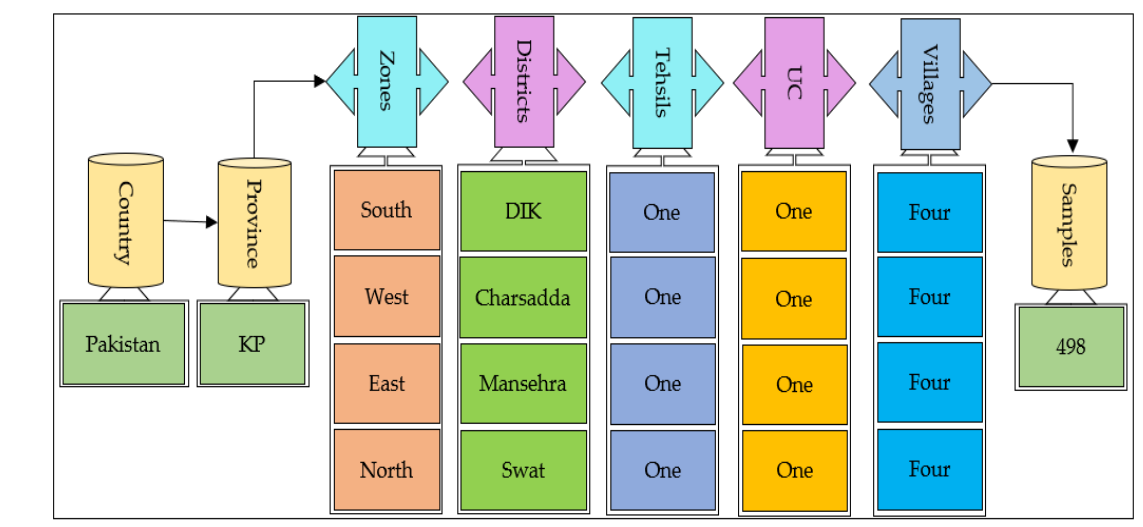
Figure 2. Sample distribution.